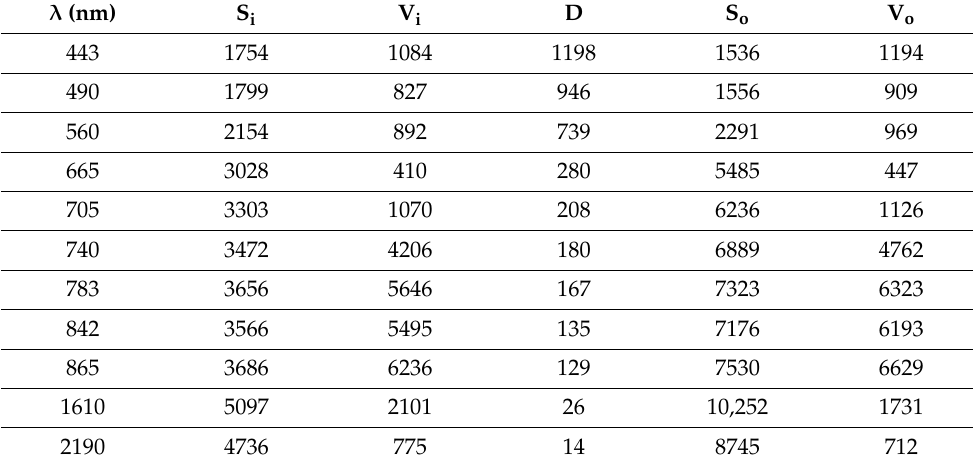
Table 3. Sentinel 2 MSI Spectral Endmembers (Exoatmospheric reflectance ×